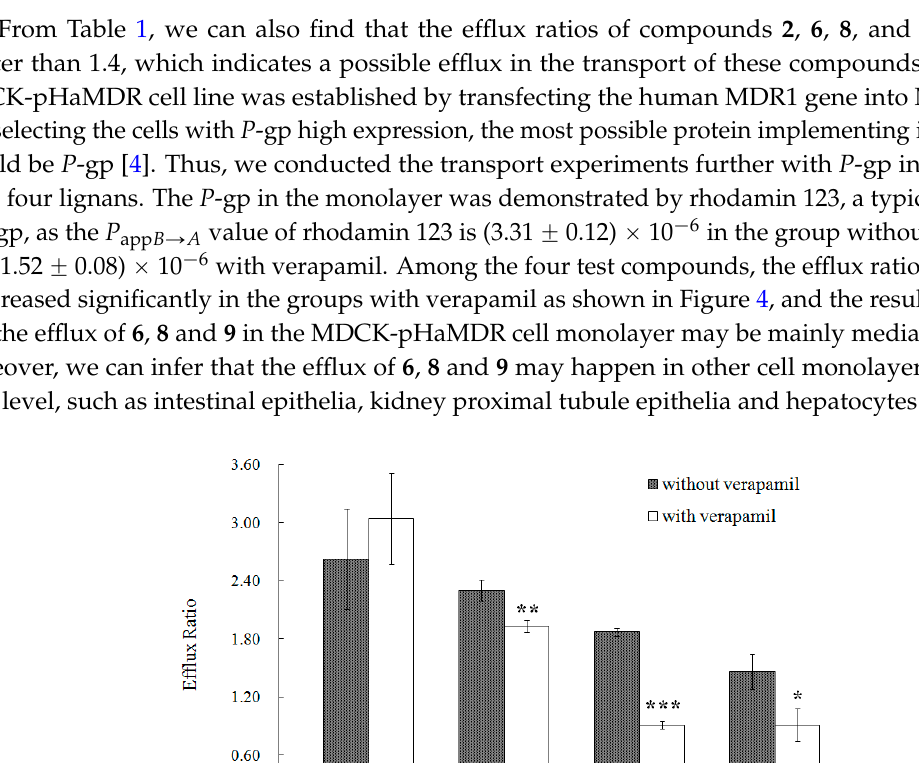
Figure 3. The sigmoid-like relationship between log ( P app A → B × MW 0.5 ) and log D (at pH 7.35) of the twelve test lignans 1 – 12 .